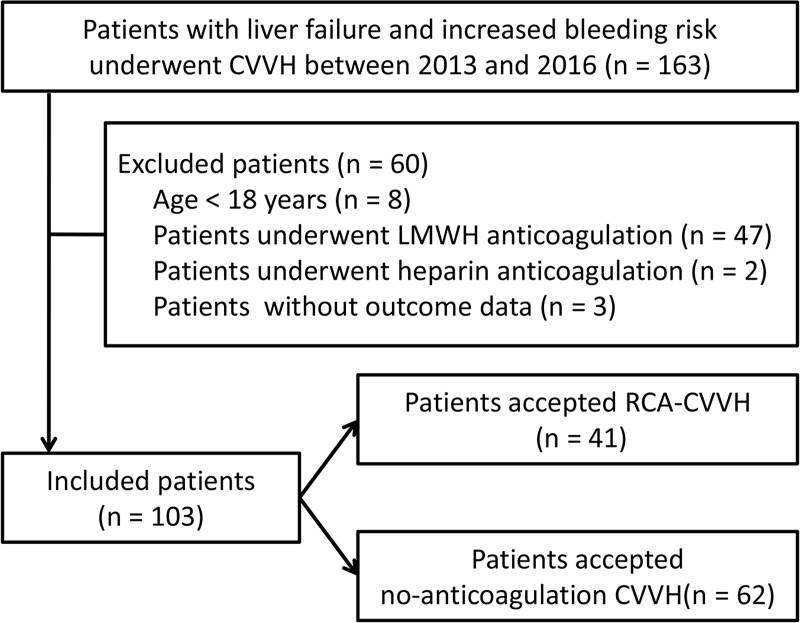
Patient inclusion flowchart.